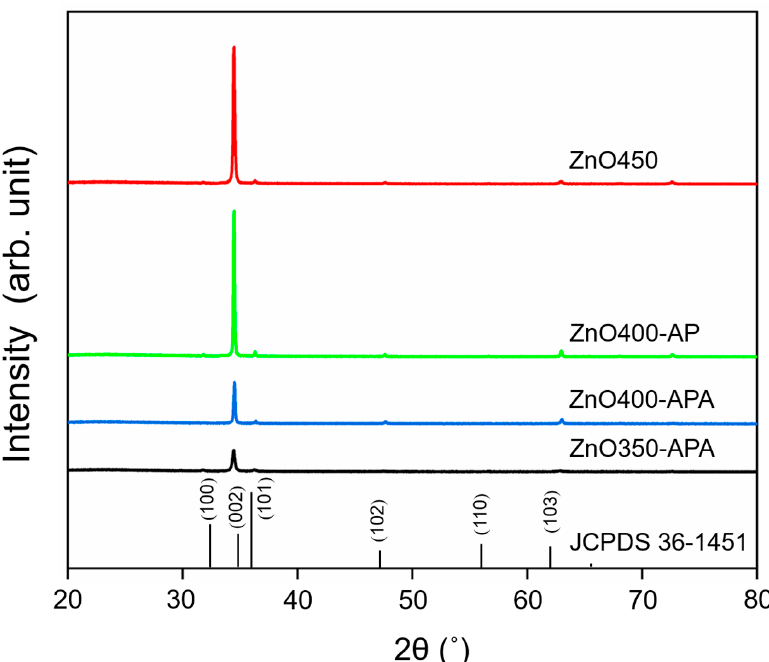
Figure 6. X-ray diffraction of ZnO obtained through different processes, indexed to the ZnO phase (JCPDS Card no. 36-1451). The three digits represent the preparation temperature of ultrasonic spray pyrolysis; AP stands for the atmospheric microplasma-assisted process; APA indicates ZnO prepared using the atmospheric microplasma-assisted ultrasonic spray pyrolysis process and vacuum annealing processes.